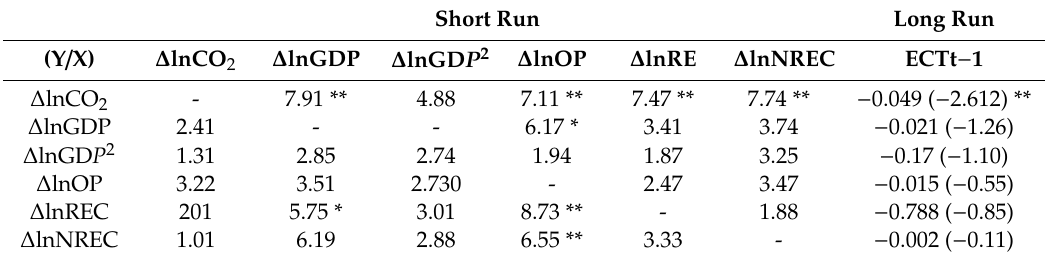
Table 9. Results of the Granger causality